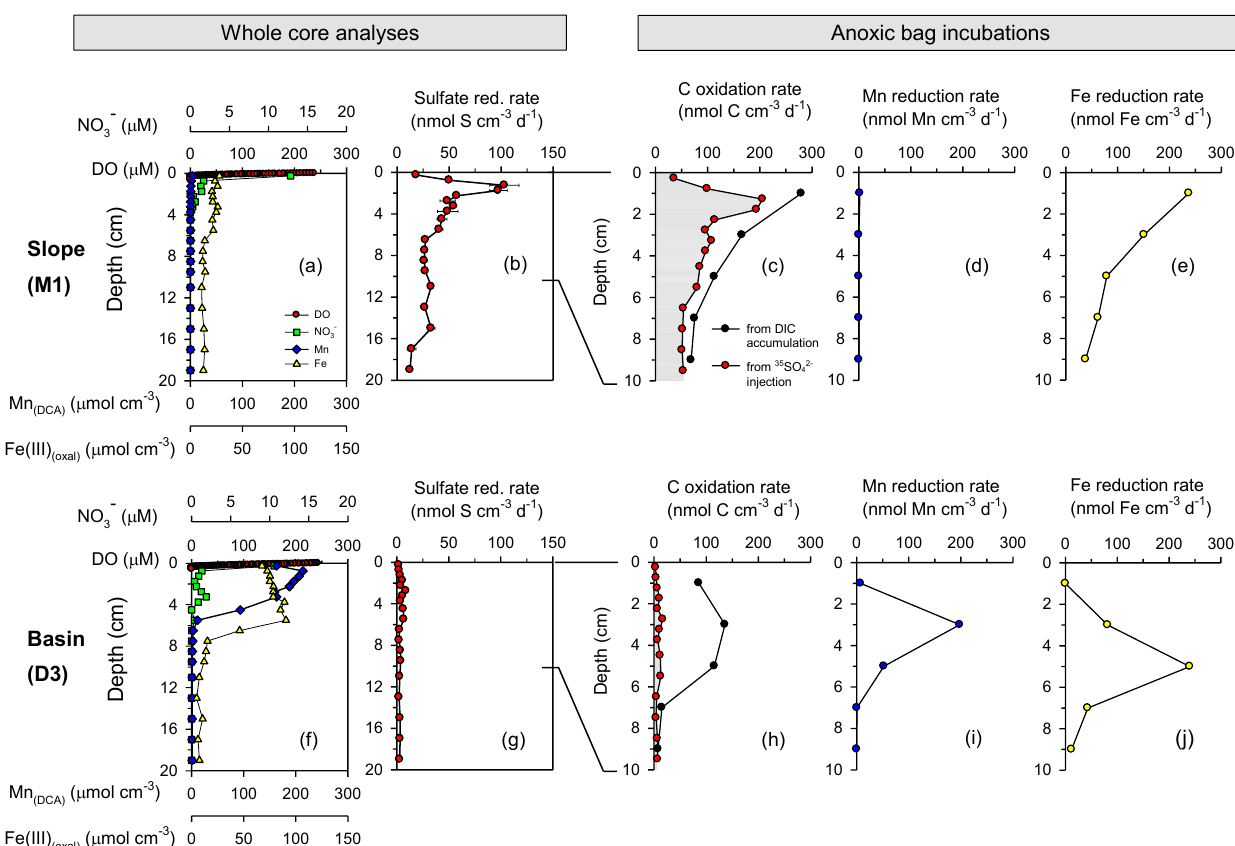
Figure 5. Vertical distribution of terminal electron acceptors (O 2 , NO − , Mn, and Fe) and rates of sulfate reduction measured from whole 3 core analyses, and rates of anaerobic carbon oxidation (DIC production rates), Mn reduction, and Fe reduction measured from anoxic bag incubations in Fig. 4. C org by sulfate reduction in (c, h) was calculated from the stoichiometry of 2:1 of C org oxidized to sulfate reduced.